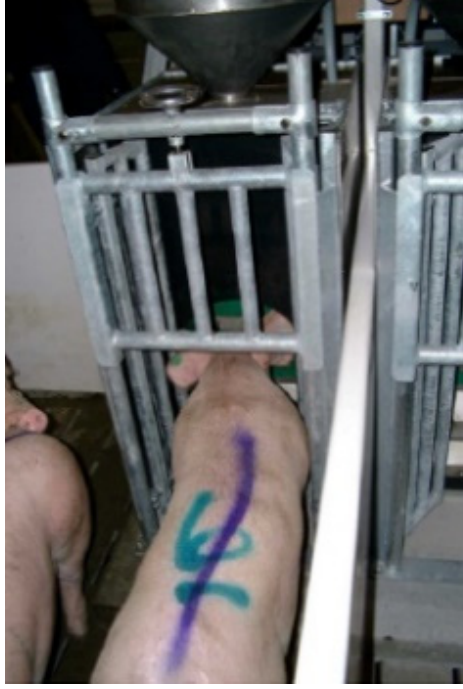
Figure 2. IVOG—A station for individual feed intake recording in group housing (Instentec B.V., Marknesse, the Netherlands) used in the studies of De Haer and Merks, [12], De Haer et al. [10], De Haer and de Vries, [8], Georgsson and Svendsen, [47,48], Rauw et al. [4], and Fernández et al. [26] (Source: [www.insentec.eu], accessed on 5 April 2022).